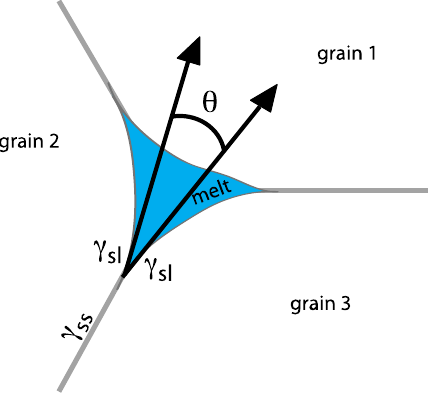
Figure 2. Schematic diagram of a triple junction containing melt between three ice grains. The morphology of the melt phase is characterized by the dihedral angle θ , which is a function of the relative solid–solid and solid–liquid interfacial energies.